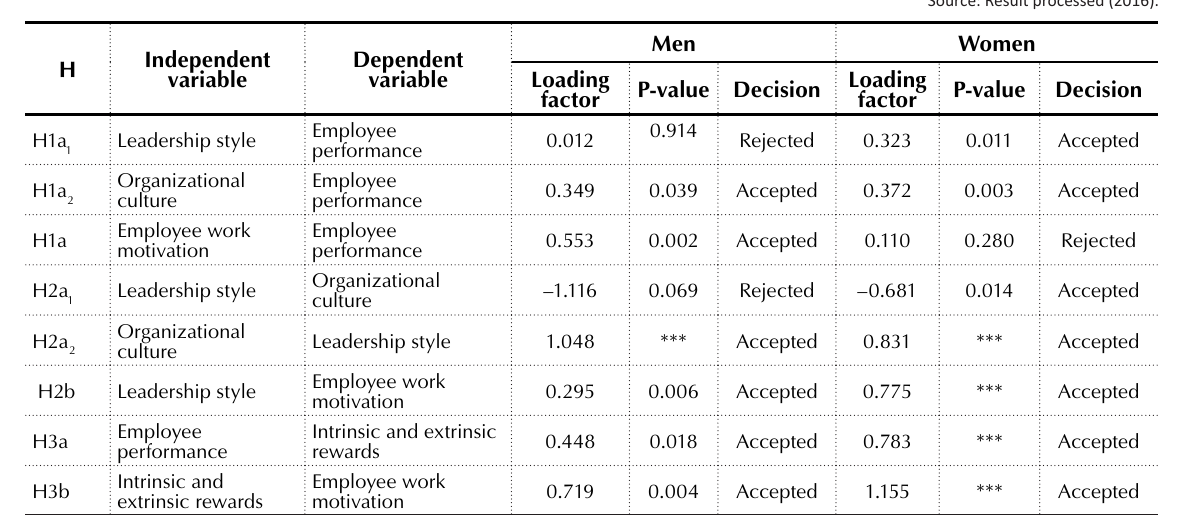
Table 1. The comparison of the relations of variables between male and female middle managers